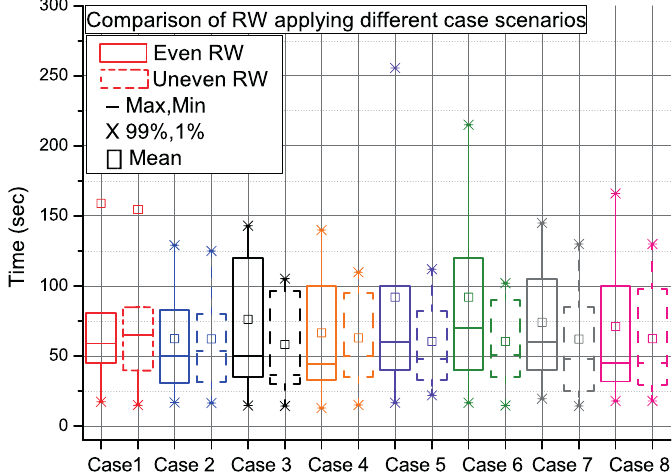
Figure 12. Comparison of RW factor from cases 1 to 8 by applying strategy A under